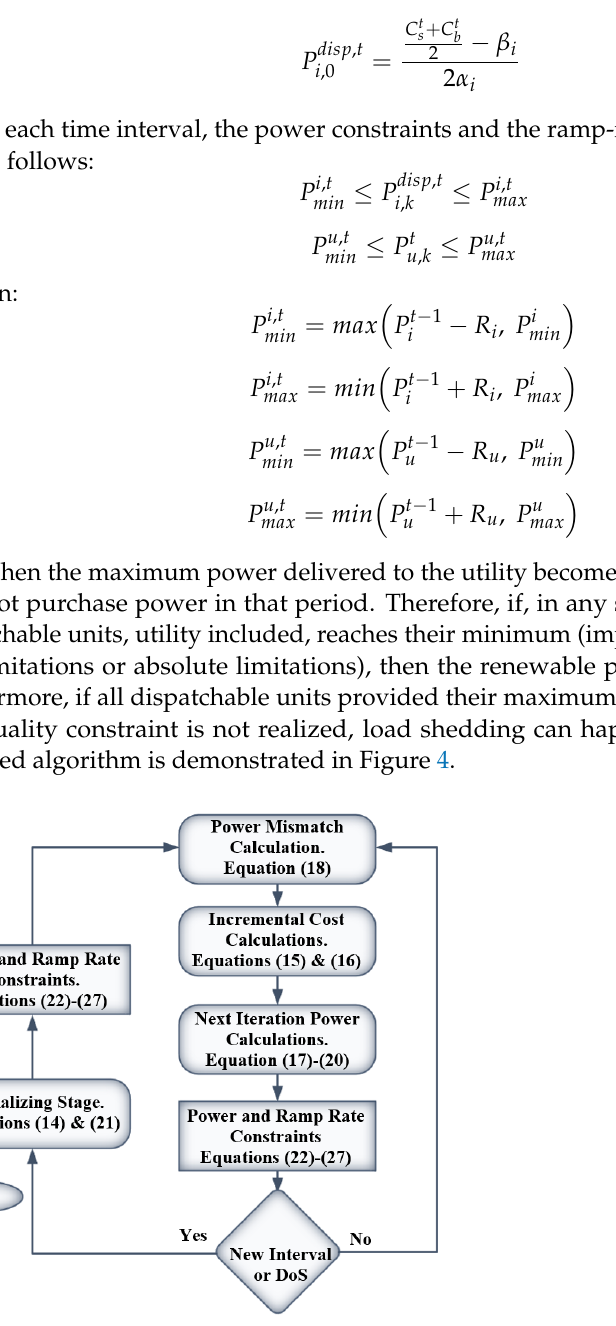
Figure 4. The proposed algorithm